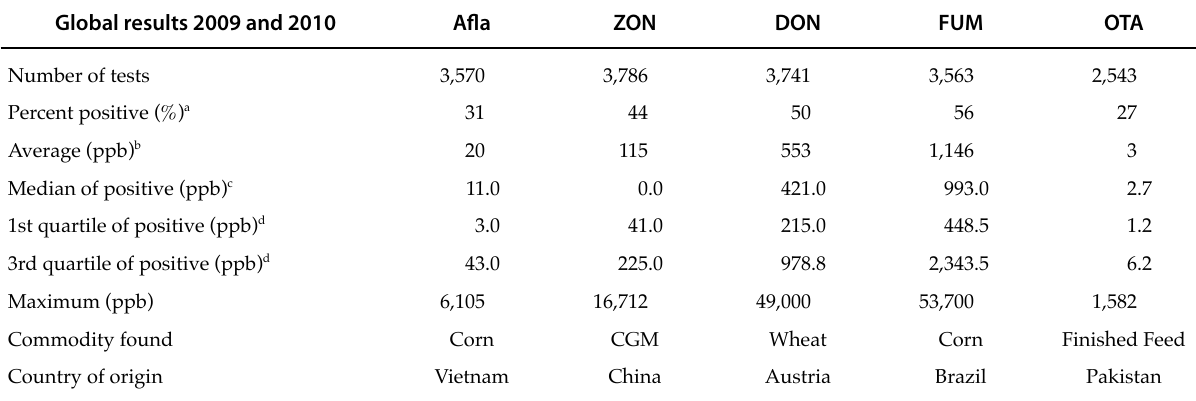
Table 3. Overview of the survey (HPLC). Global results 2009 and